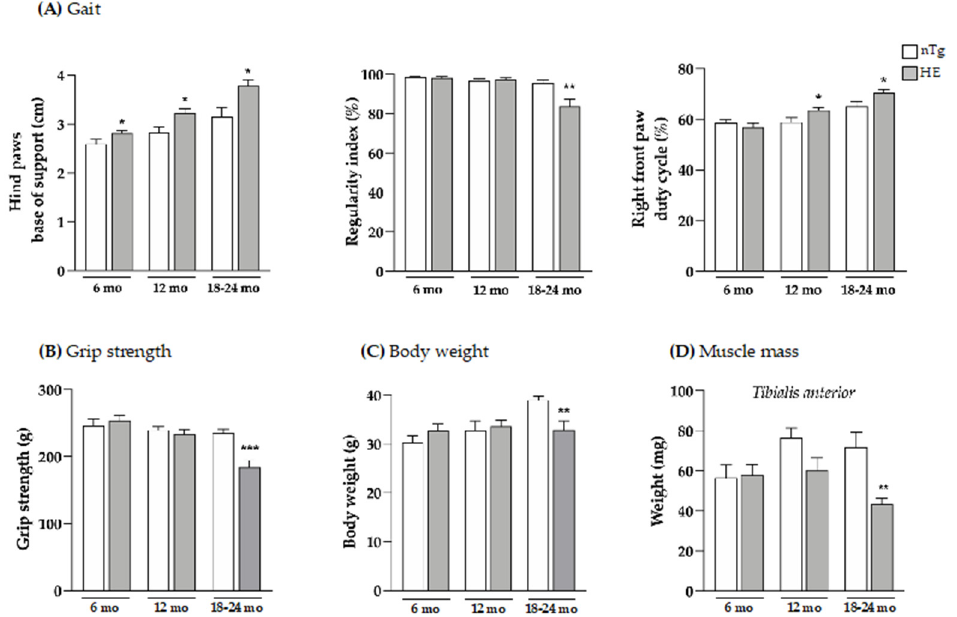
Figure 1. Neuronal expression of CHMP2B intron5 induces progressive gait abnormalities and alters muscle parameters. Gait ( A ), grip strength ( B ), body weight ( C ), and weight of tibialis anterior muscle ( D ) were evaluated at three ages. HE mice were compared to age-matched nTg mice. Histograms represent means ± SEM; A: n = 9 – 16/group; B: n = 11 – 13/group; C: n = 12/group; and D: n = 4 – 6/group. * p < 0.05, ** p < 0.01, *** p < 0.001, Student’s t test ( A , B , and D ) or Mann – Whitney test ( C ).